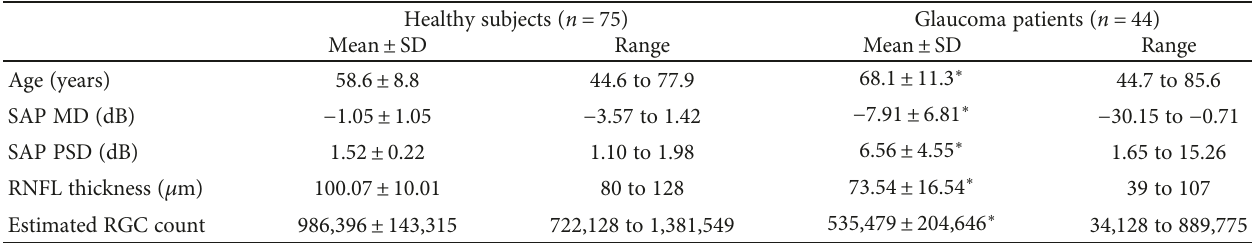
Table 1: Demographic and clinical characteristics of the study participants ( n = 119